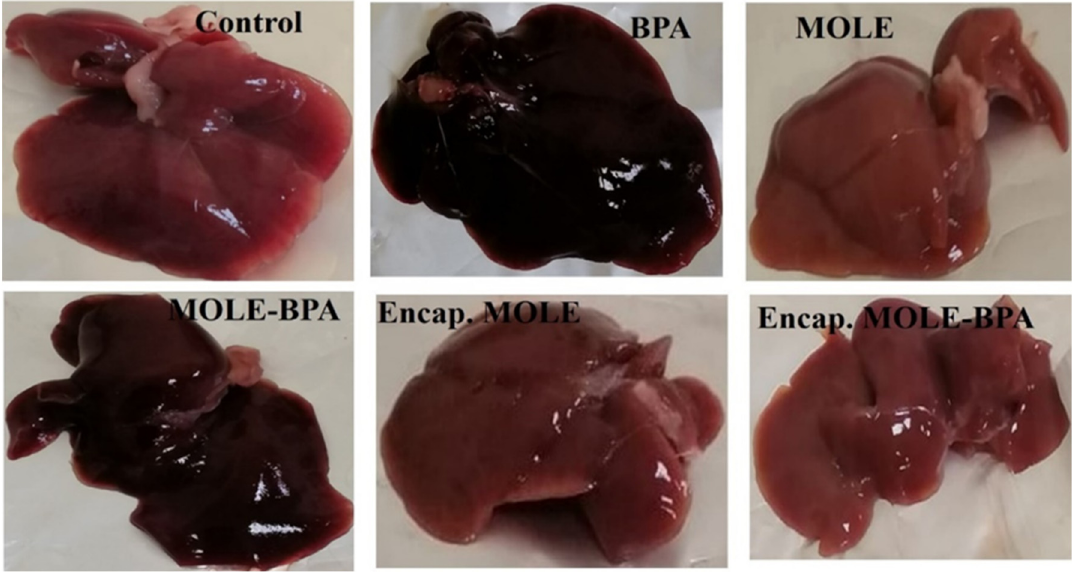
Figure 10. Photomicrograph of individual livers showing the morphological appearance.